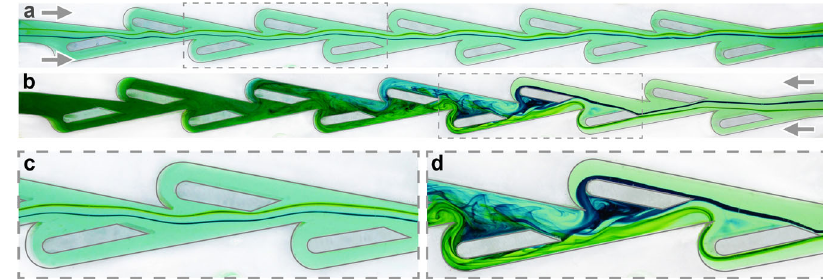
Fig. 3 Streakline fl ow visualization at Re ¼ 200 using dye injected upstream. a , c Forward direction. Two adjacent fi laments remain in the central corridor of the conduit with only small lateral de fl ections. b , d Reverse direction. The fi laments ricochet off the periodic structures, de fl ecting increasingly sharply before being rerouted around the `islands ’ and